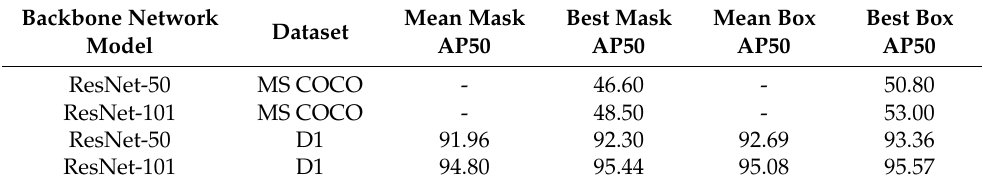
Table 4. Model performances under different backbone network